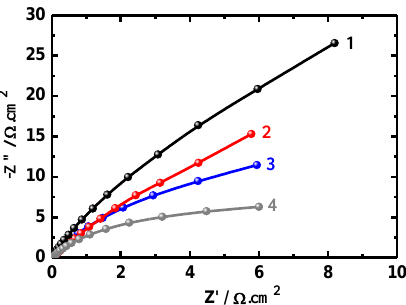
Figure 7. Nyquist plots for γ-TiAl alloy in 3.5% NaCl solution at (1) 30 °C; (2) 40 °C; (3) 50 °C; and (4) 60 °C, respectively.